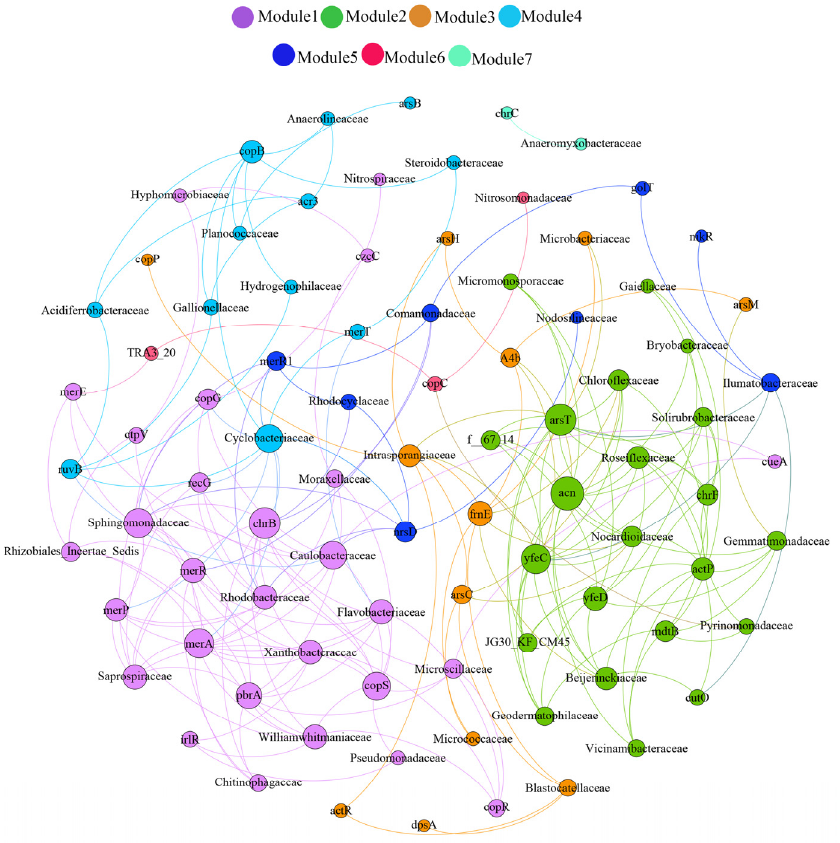
Figure 5. Network analysis revealing co-occurrence patterns among MRGs and bacteria (family level). Each connection represents a strong (r > 0.6) and significant ( p < 0.05) relationship. The node size is proportional to the connection number—the larger the connection number, the larger the node size.